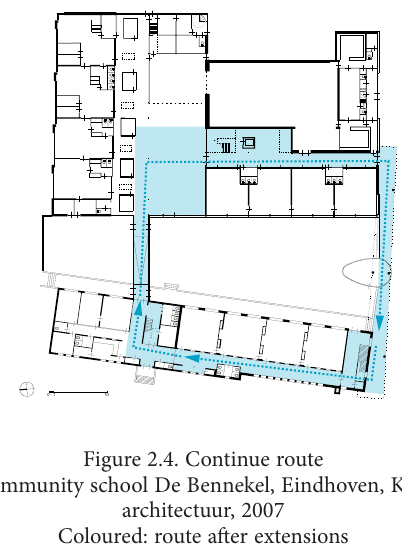
Figure 2.1−2.9 present typical examples of conversion